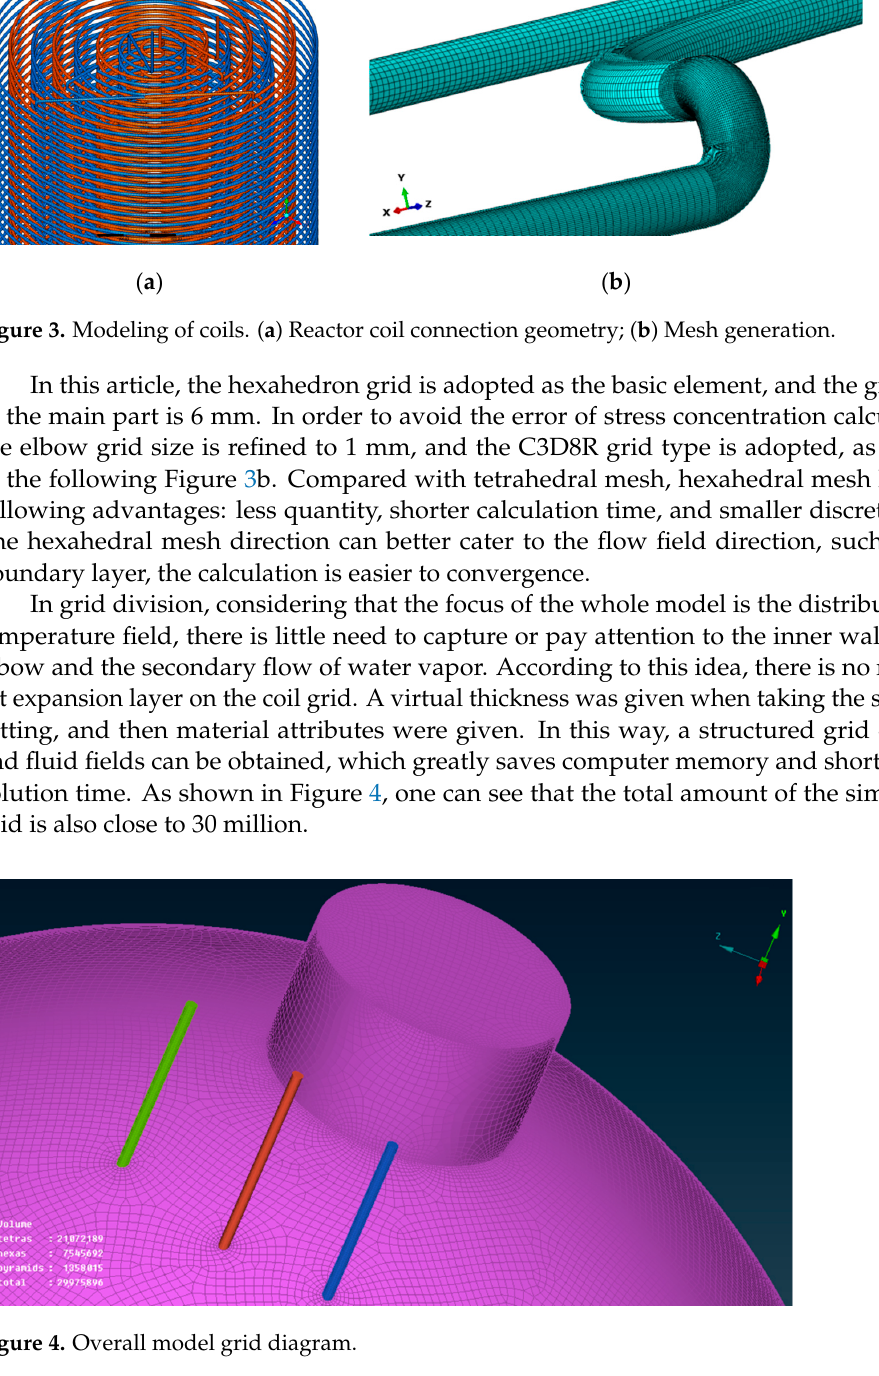
Figure 4. Overall model grid diagram.